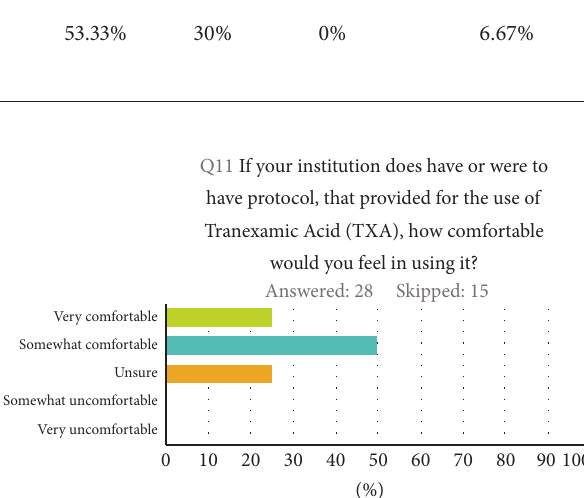
Figure 2: How comfortable would you feel to use TXA in exsanguinating trauma patients if TXA were incorporated in your institution massive transfusion